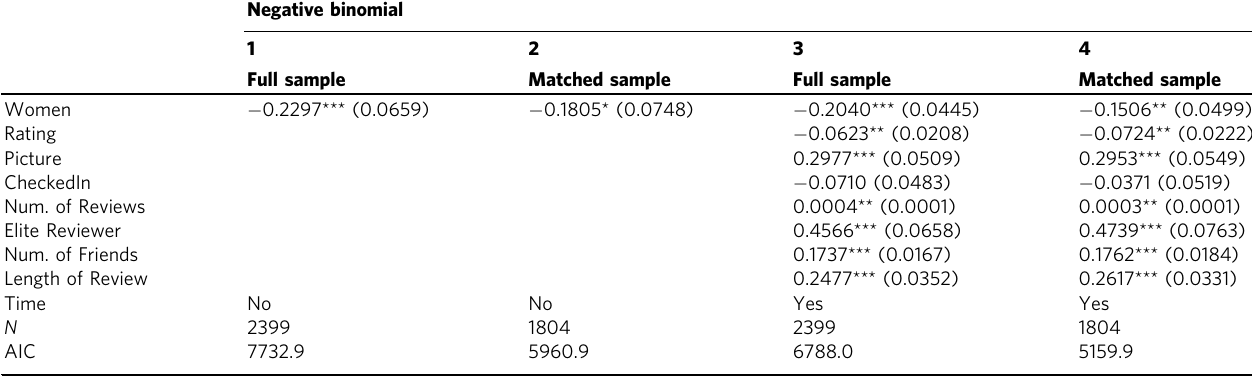
Table 3 Results of the relationship between gender and review usefulness votes.